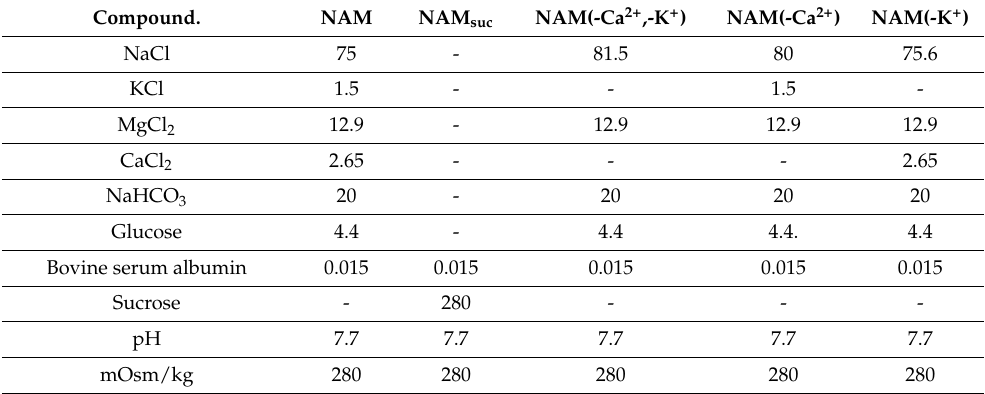
Table 1. Composition of the different non-activating mediums (NAM) employed in this study (in mM).